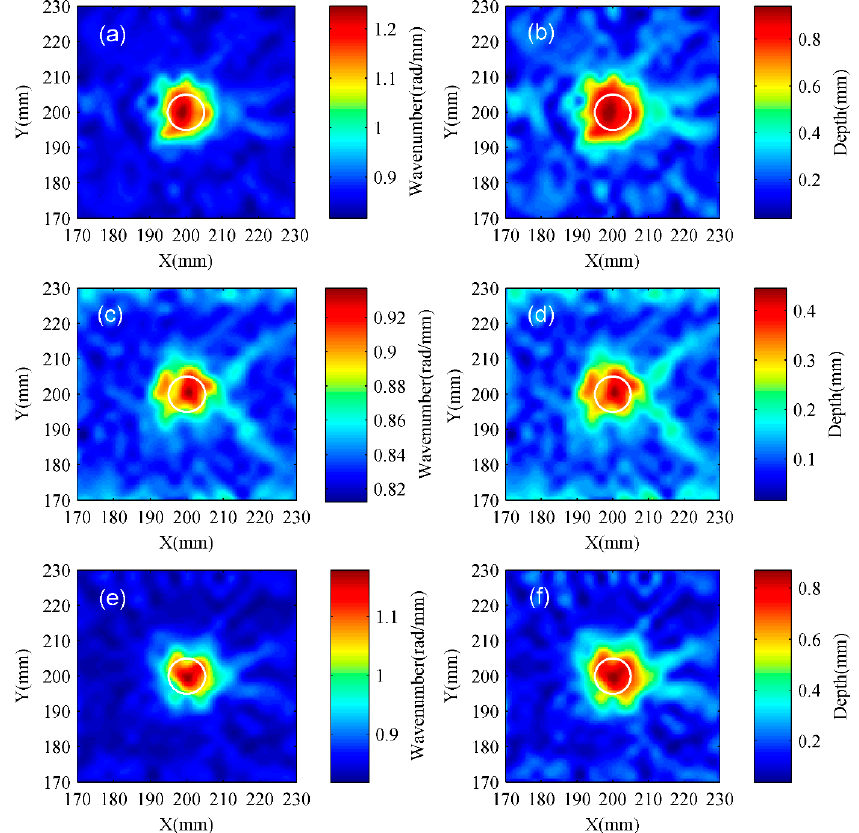
Figure 18. Experimental results of Case 1 to Case 3. ( a ) Wavenumber distribution of Case 1; ( b ) depth distribution of Case 1; ( c ) wavenumber distribution of Case 2; ( b ) depth distribution of Case